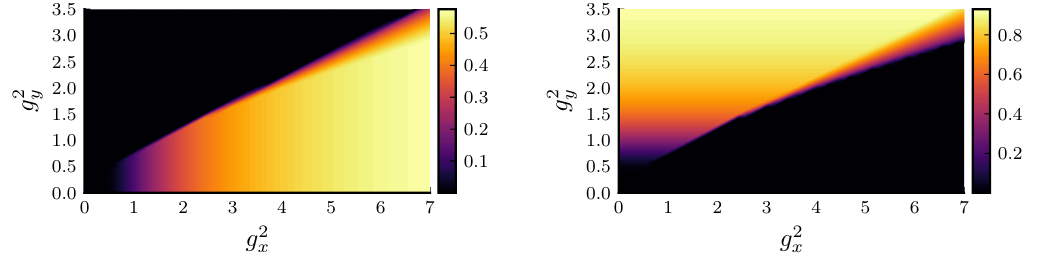
Figure 2 . The value of the order parameters σ (left) and π (right) that minimize the large- N effective potential V L ( σ, π ) as a function of the two couplings g 2 eff